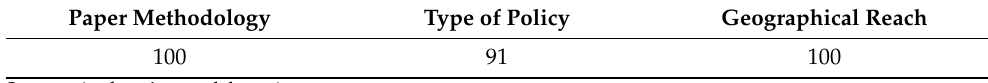
Table 1. Inter-coder reliability of the coding dimensions (percentage agreement, %).